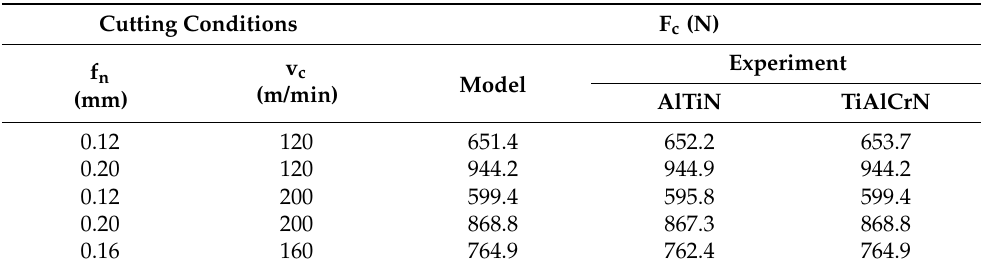
Table 13. Calculated and experimental cutting force values of coated cutting tool inserts.